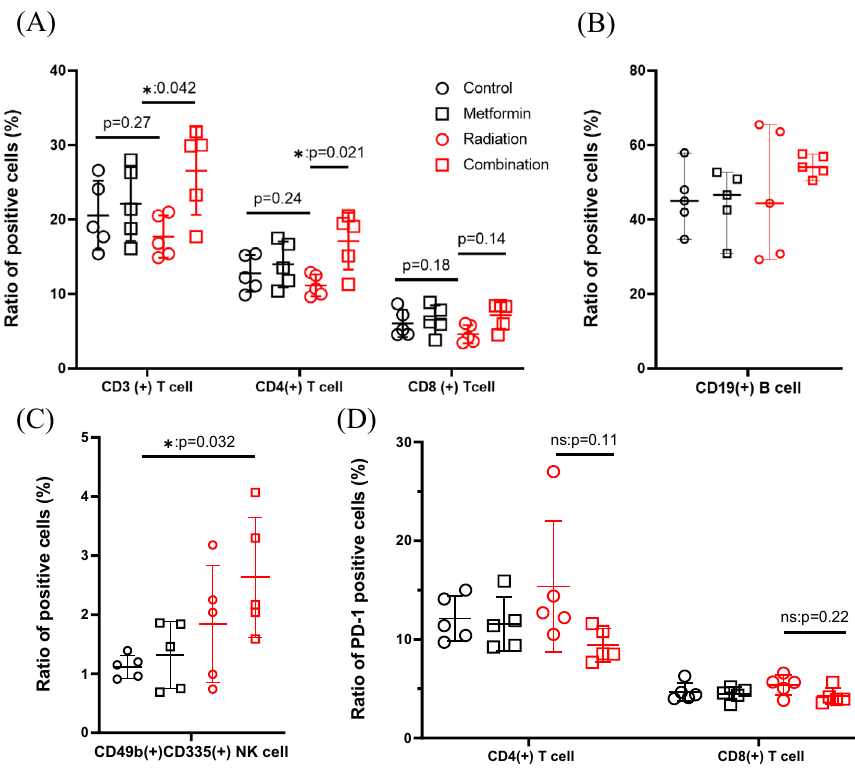
Figure 4. Splenocytes were harvested at day 28 and immunostained with mAbs to CD3, CD4, CD8, CD19and CD49b, CD335 and the frequencies of T ( A ), B ( B ) , activated NK ( C ) cells and PD-1(+) cells in CD4(+) or CD8(+) T cells ( D ) are determined in lymphocyte gate determined with flow cytometry. Data are shown as mean ± standard deviation of 5 mice in one of the 2 different experiments. * p <